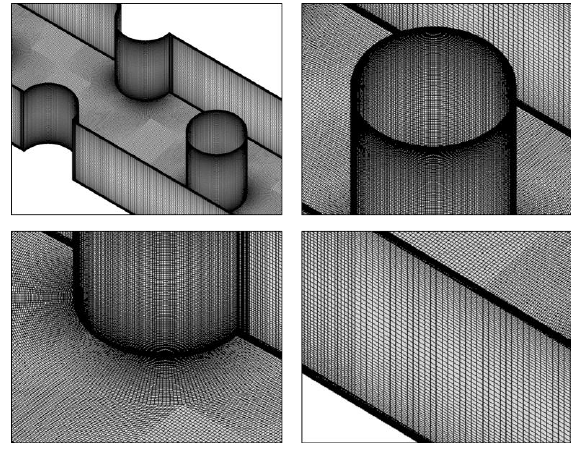
Figure 6. Grid used in the test section with pin fins. Table 3. Summary of grid and time-step size used for channel with pin fins.